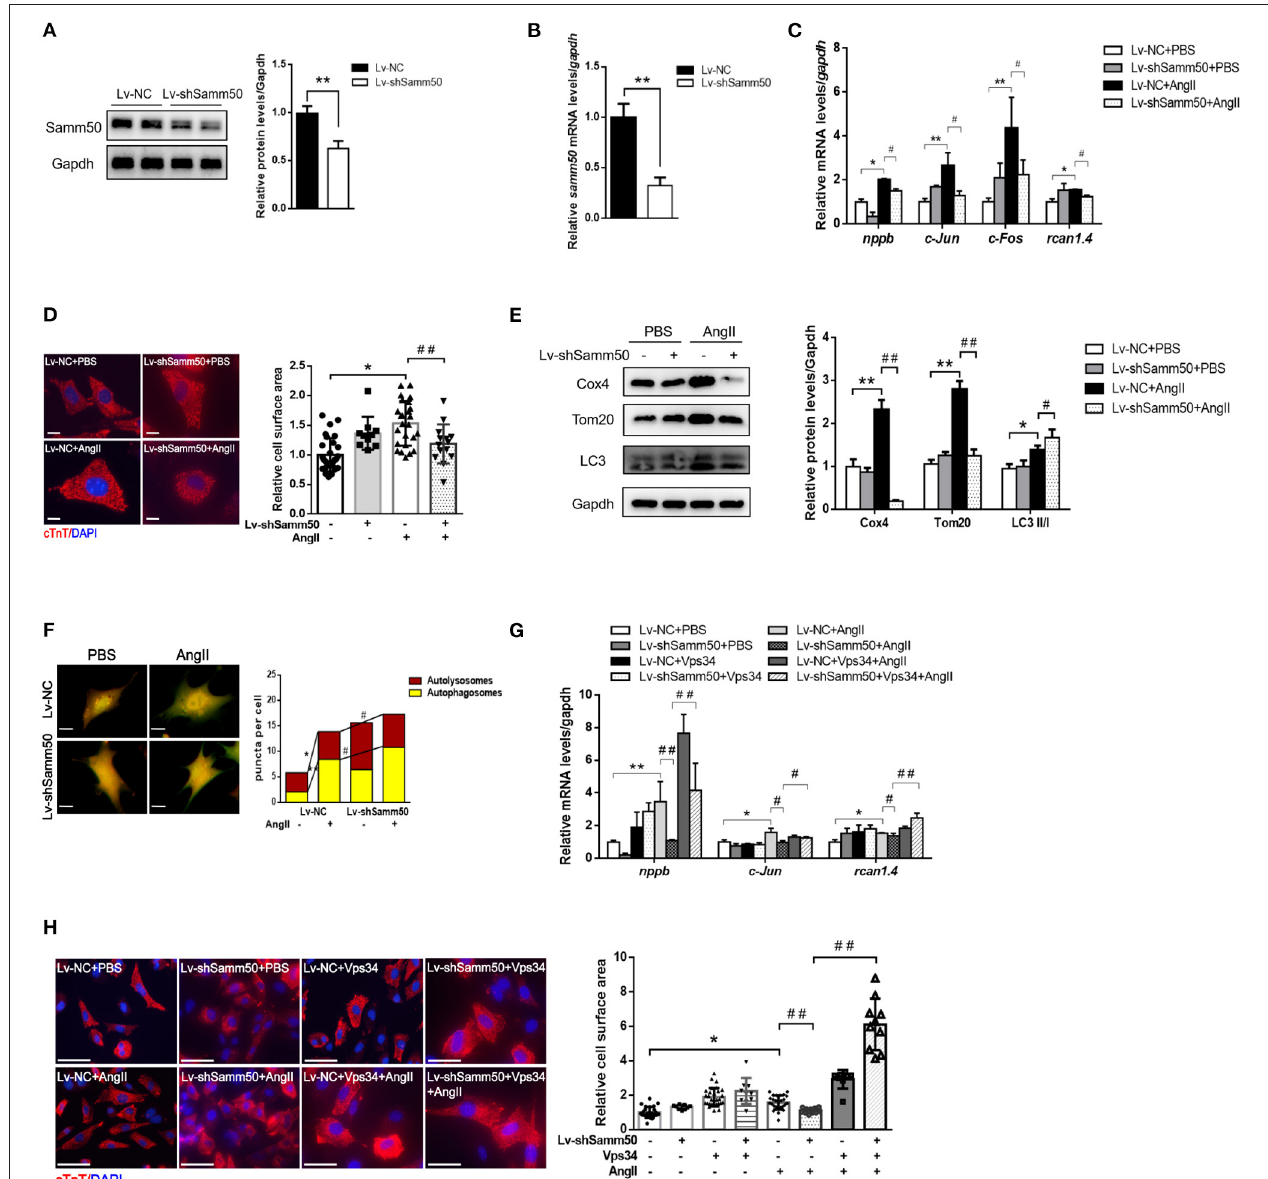
FIGURE 3 | Samm50 deficiency alleviated cardiomyocytes hypertrophy by promoting mitophagy. (A,B) WB and qRT-PCR analysis of Samm50 knockdown efficiency in mouse neonatal cardiomyocytes. (C) Relative mRNA levels of hypertrophic marker gene expression in Lv-NC or Lv-shSamm50 cardiomyocytes with Ang II treatment. Lv-NC, lentivirus with pLKO control and Lv-shSamm50, lentiviral-delivered shRNA against Samm50. (D) Representative images and calculated cell surface area of cardiomyocytes with Ang II treatment. Scale bars, 10 µ m. (E) Immunoblotting and statistical analysis of mitophagy protein levels in Lv-NC or Lv-shSamm50 cardiomyocytes treated with PBS or Ang II. (F) Representative images of fluorescent LC3 puncta and analysis results. Scale bars, 10 µ m. (G) Quantification of hypertrophic markers expression in cardiomyocytes infected with indicated lentivirus and treated with or without Vps34 inhibitor prior to Ang II stimulation. (H) Representative images and quantitative results of cell surface area in response to Ang II. Scale bars, 50 µ m. n = 6 for each experiment group. * P < 0.05 compared with the control group; ** P < 0.01 compared with the control group; # P < 0.05 compared with Ang II group; and ## P < 0.01 compared with Ang II group. All data are presented as mean ±